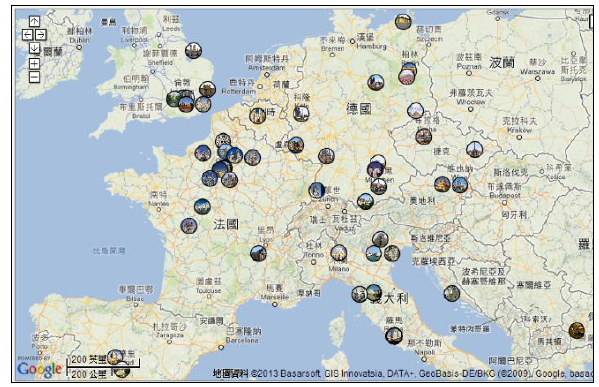
Figure 11. Map mode view showed data